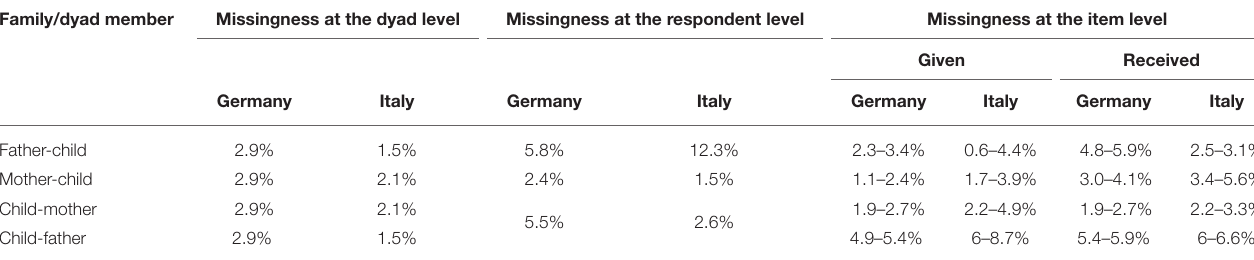
TABLE 2 | Missingness rates at the dyad, respondent, and item level for the German and Italian samples. Family/dyad